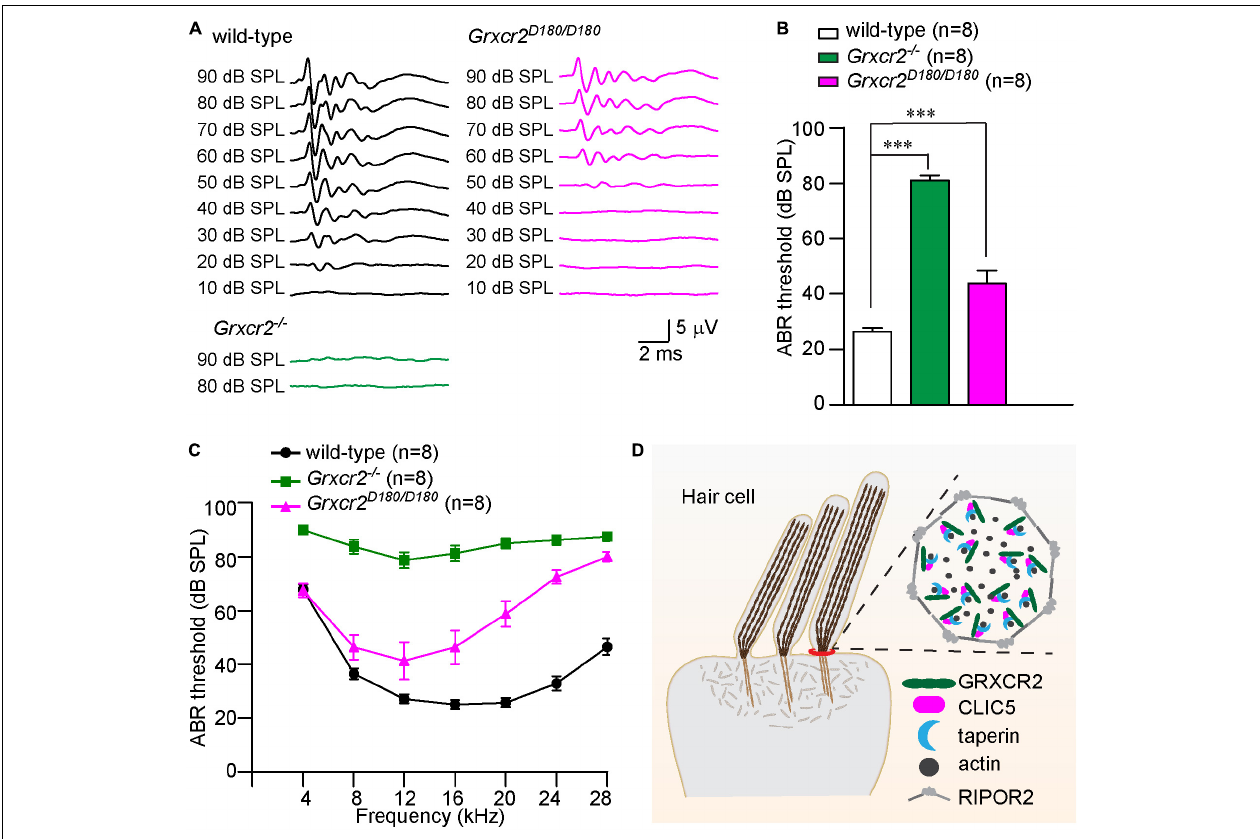
FIGURE 4 | Disrupting the interaction between GRXCR2 and CLIC5 leads to hearing loss in mice. (A) Representative ABR traces to click stimuli in wild-type (black traces), Grxcr2 − / − (green traces), and Grxcr2 D 180 / D 180 mice (red traces). Note, Grxcr2 − / − mice had profound hearing loss while Grxcr2 D 180 / D 180 mice have moderate hearing loss. (B) ABR thresholds for click stimuli in 6-week-old wild-type, Grxcr2 − / − and Grxcr2 D 180 / D 180 mice. All values are represented as the mean ± SEM. *** p < 0.001, Student’s t test. (C) ABR thresholds for pure tones in 6-week-old wild-type, Grxcr2 − / − and Grxcr2 D 180 / D 180 mice. P < 0.001 between wild-type and Grxcr2 − / − mice, wild-type and Grxcr2 D 180 / D 180 mice, Grxcr2 − / − and Grxcr2 D 180 / D 180 mice (two-way ANOVA). (D) Model of GRXCR2 protein complex at the base of stereocilia. In our model, GRXCR2 forms a protein complex with CLIC5 and taperin, which is surrounded by a circumferential ring structure formed by RIPOR2 (previously named as Fam65b) oligomers. GRXCR2 and CLIC5 regulate the localization of taperin, which is an actin cytoskeleton regulatory protein located at the base of